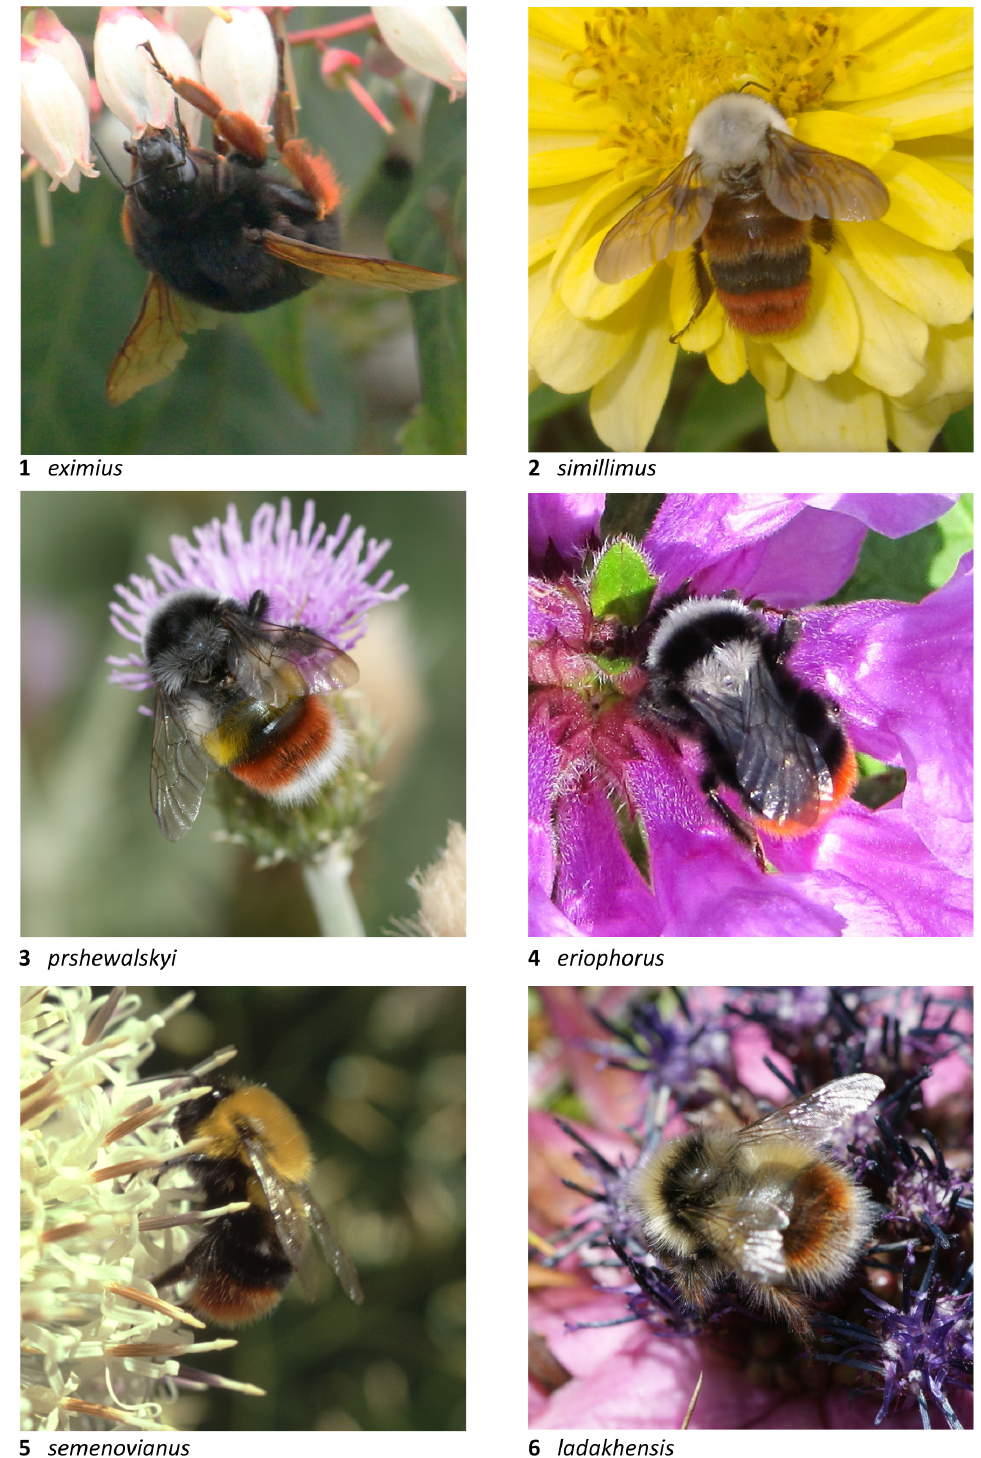
Figs 1‒6. Individuals of the subgenus Melanobombus von Dalla Torre, 1880 (with photo credits). 1 . Bombus eximius Smith, 1852, queen, Thailand (CT). 2 . B. simillimus Smith, 1852, worker, India- Kashmir (RR). 3 . B. prshewalskyi Morawitz, 1880, worker, China-Gansu (PW). 4 . B. eriophorus Klug, 1807, queen, Georgia (I. Popov). 5 . B. semenovianus (Skorikov, 1914), male, India-Kashmir (PW). 6 . B. ladakhensis Richards, 1928, male, China-Gansu (PW). Some images